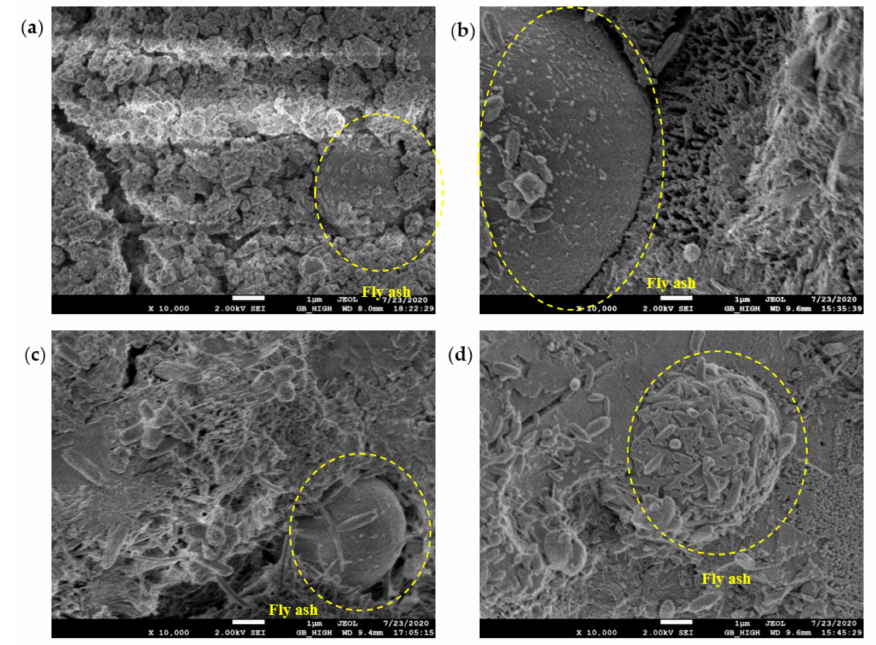
Figure 11. SEM diagram of pure cement paste (FA replacement ratio is 30%) at 7 days of age: